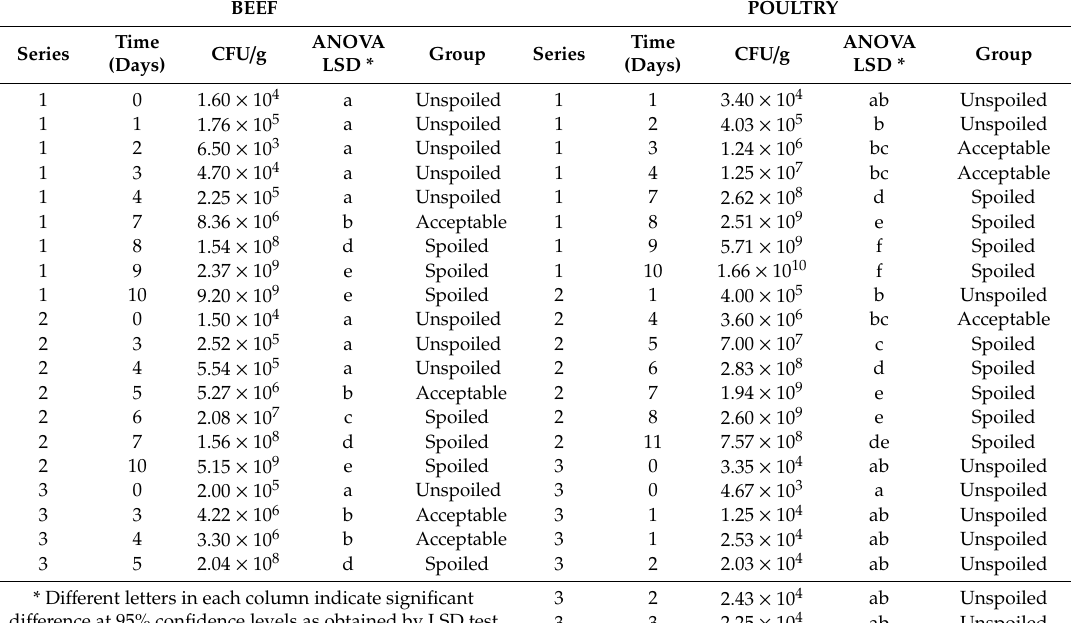
Table 4. One-way ANOVA and Least Significant Di ff erence (LSD) test applied on microbiological data (Total Viable Count, CFU / g of product) collected on beef and poultry samples.